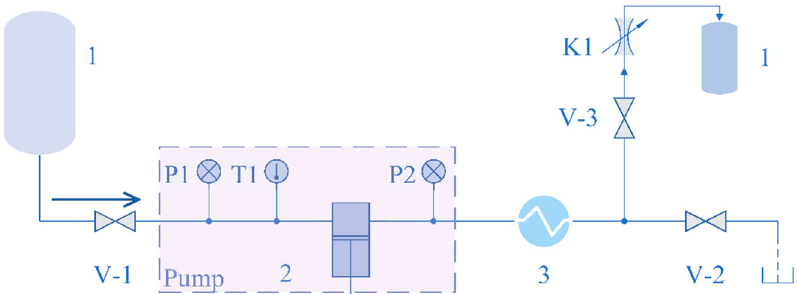
Figure 14. Sketch of liquid hydrogen pump pressure vaporization test system. P1, P2 are pressure sensors, T1 is a temperature sensor. 1 is the liquid hydrogen storage tank, 2 is the liquid hydrogen pump, 3 is the vaporizer. V-1 is the suction valve, V-2 is the degassing valve, V-3 is the exhaust valve, and K1 is the throttling element.